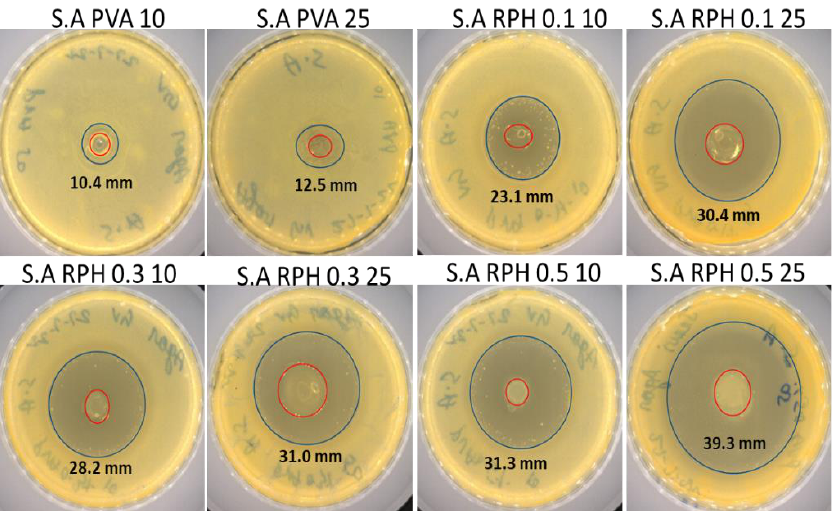
Figure 5. Representative macroscopic images of the antibacterial capacity of the RPHX hydrogels. The upper panel shows positive control of E. coli and S. aureus using amphotericin B (20 µ L) and penicillin (20 µ L). The lower panel shows the antibacterial efficacy of RPHX by using the disk diffusion method using both E. coli (mm) and S. aureus (mm) strains. Control strains treated without hydrogel, PVA solution 15 wt.%, RPH 0.1-0.1% retinol PVA, RPH 0.3-0.3% retinol PVA, RPH 0.5-0.5% retinol PVA hydrogel. The numbers 10 and 25 correspond to strains treated with 10 µ L and 25 µ L of RPHX hydrogel, respectively. Table 2. Antimicrobial activity of retinol-loaded PVA hydrogel by disk diffusion method. Hydrogels